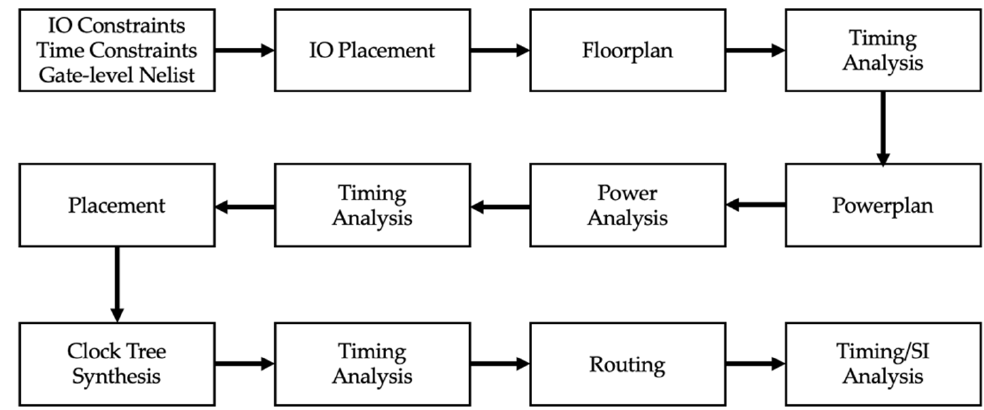
Figure 4. The proposed entity makes a flow chart of the architecture of the verification